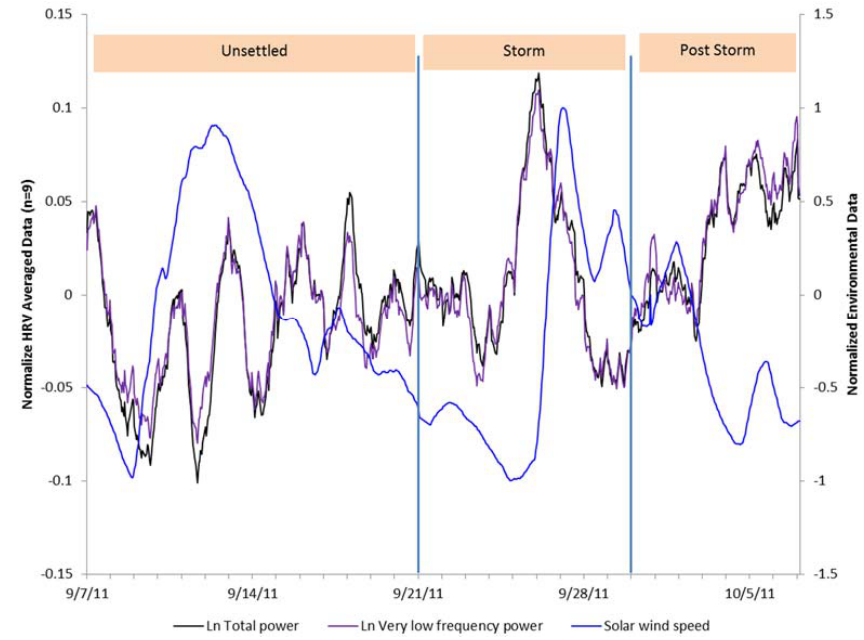
Figure 6. HRV total power and very low frequency power measures with solar wind speed variations overlaid.